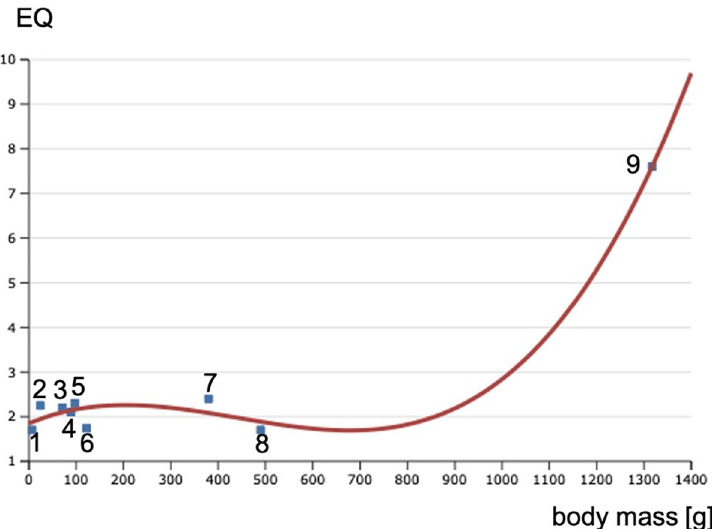
Fig 5. Polynomial regression of degree 3 shows a strong correlation between Encephalization Quotient (EQ) and brain mass (R 2 = 0.98197). A linear regression was also performed (R 2 = 0.081803). From left to right, the points correspond to Callithrix (1), Macaca (2), Hylobates (3), Brachyteles (4), Saimiri (5), Sapajus (6), Pan (7), Gorilla (8) and Homo sapiens (9).